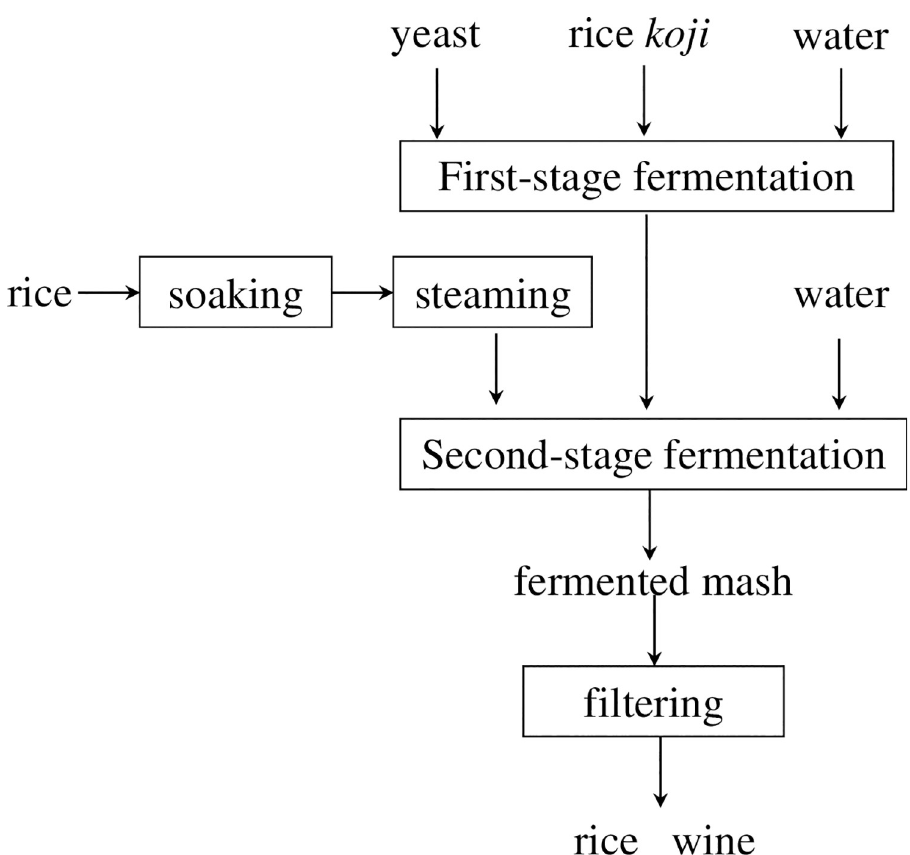
Fig 1. Flow diagram of rice wine production.